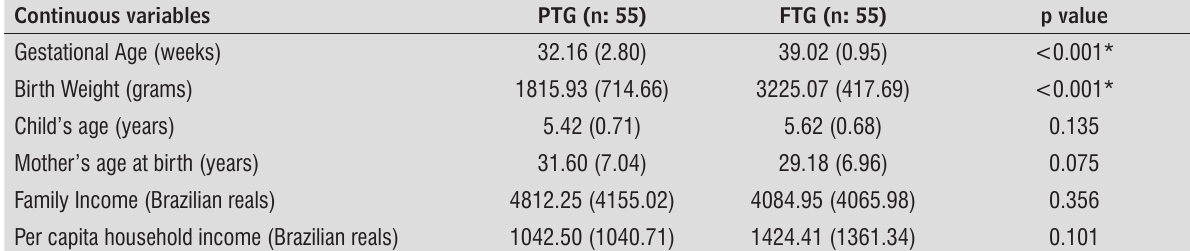
Table 1 - Characteristics of the study participants according to continuous variables Continuous variables